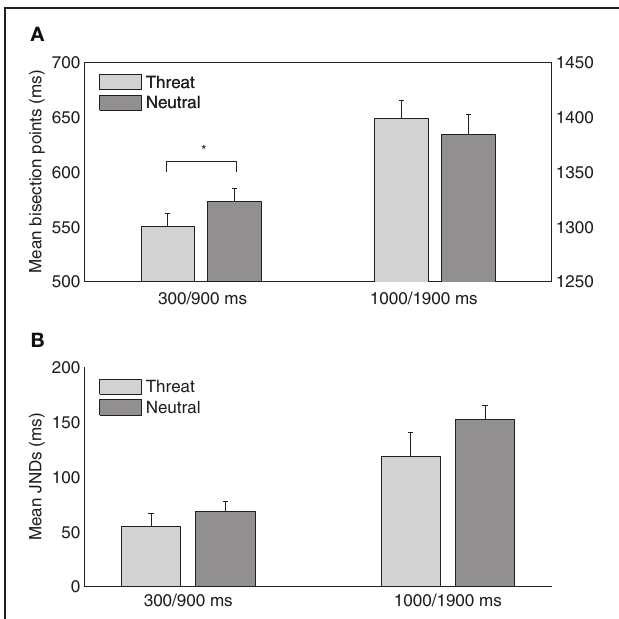
FIGURE 3 | (A) Mean temporal bisection points and (B) mean JNDs (and associated standard errors) plotted against threat and neutral picture conditions, for the short-range (300/900 ms) and the long-range (1000/1900 ms) sessions ( n = 15).